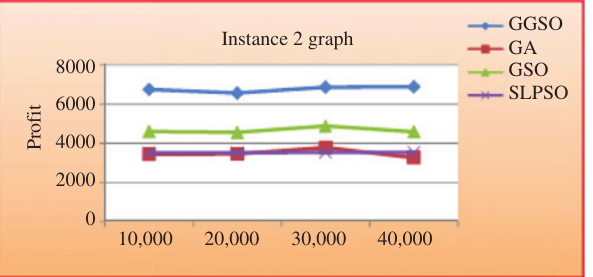
Figure 4: Performance of Profit Plot Proposed Against Existing Algorithm for instance 2.